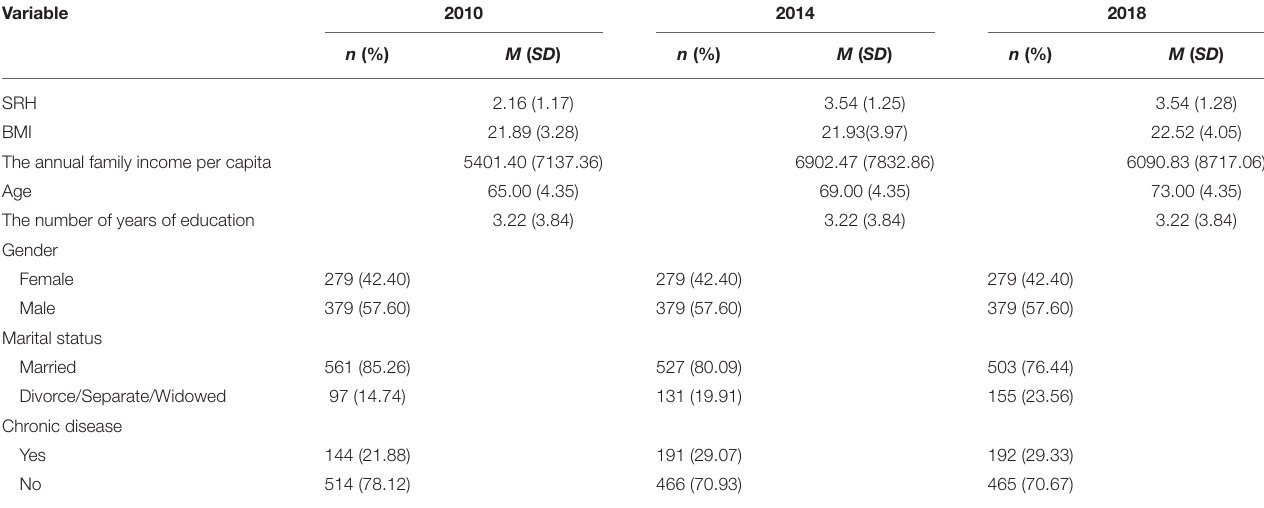
TABLE 1 | Characteristics of the